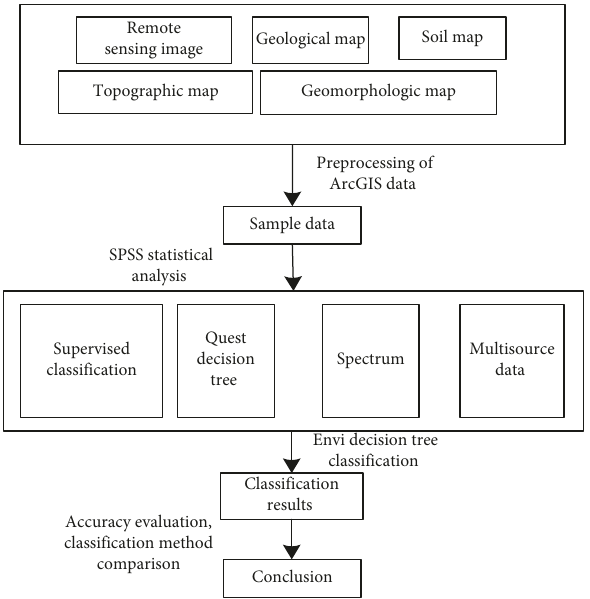
Figure 1: Land use classification and extraction